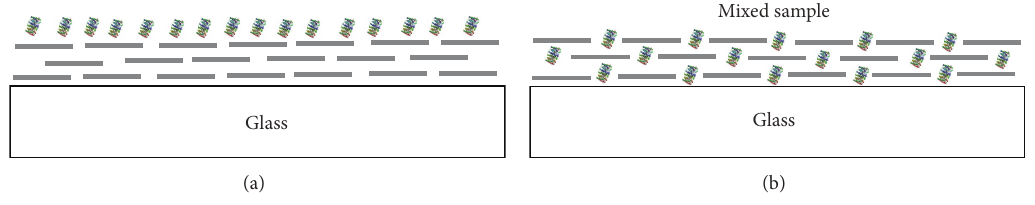
Figure 3: Geometries of hybrid nanostructures comprising the PCP complexes and silver nanowires studied in this work: (a) lbl (layer-by- layer) and (b) mixed structure. Dashed lines:AgNWs; colored objects:PCP complexes. The scale is not conserved.